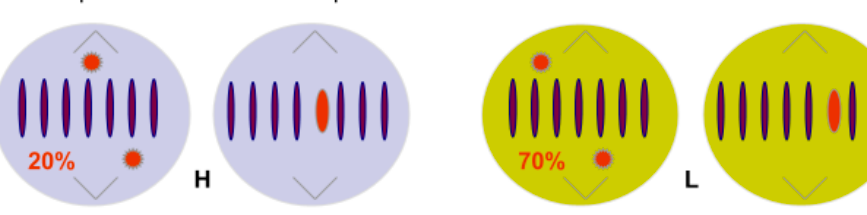
Figure 2 . Metaphase of meiosis in 2B plants of two transmission genotypes of Korean rye, based on Jiménez et al [20]. Genotypes were selected homozygous for A chromosome ‘genes’ controlling HIGH (H) and LOW (L) transmission rates of B chromosomes. Transmission rates reflect resistance of the A background to the Bs.